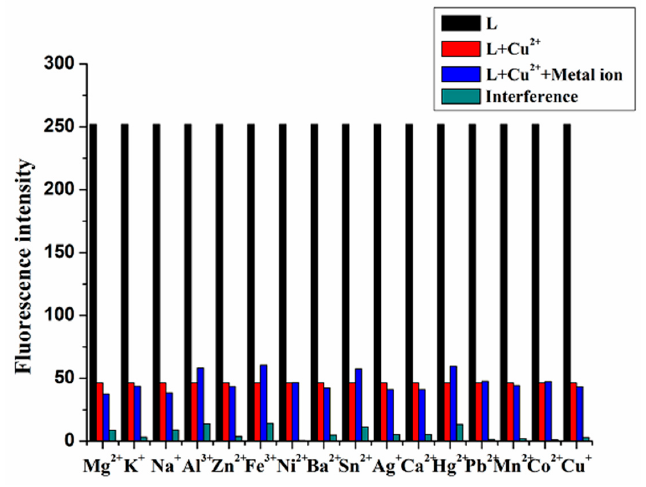
Figure 9. Interference of foreign cations. Solvents: EtOH/H 2 O (4:1 v/v ).